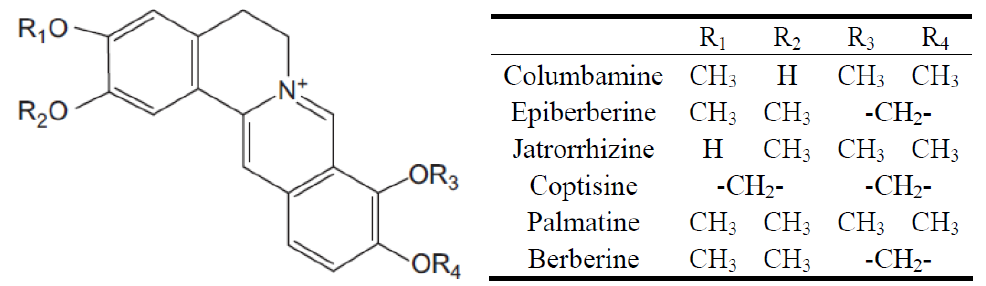
Figure 1. Structures of six tested